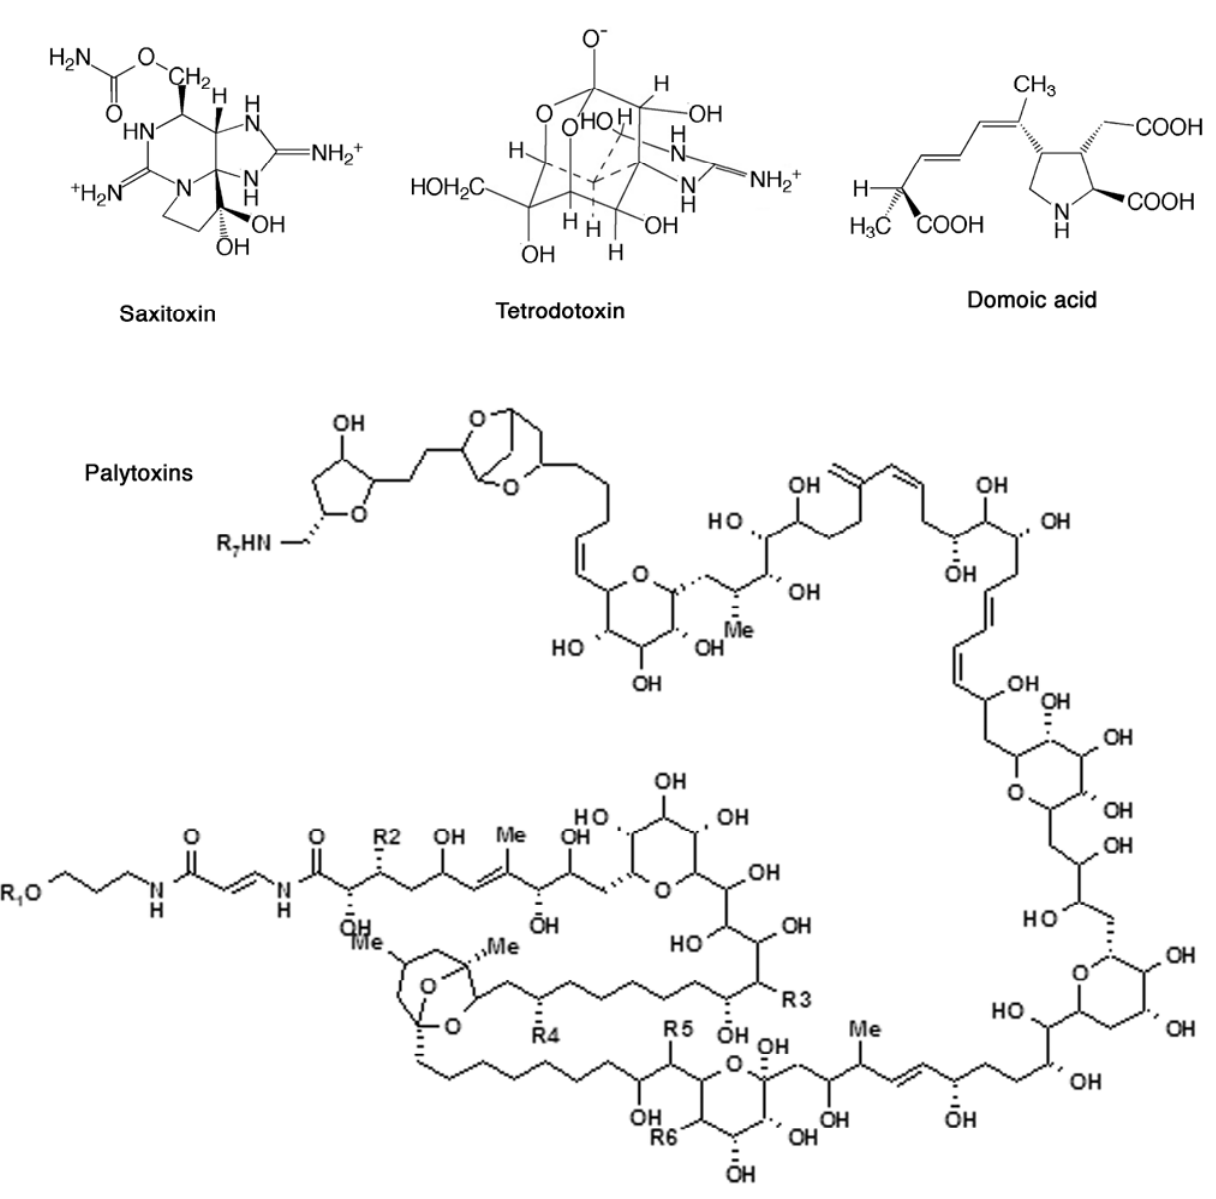
Figure 2. Chemical structures of hydrophilic